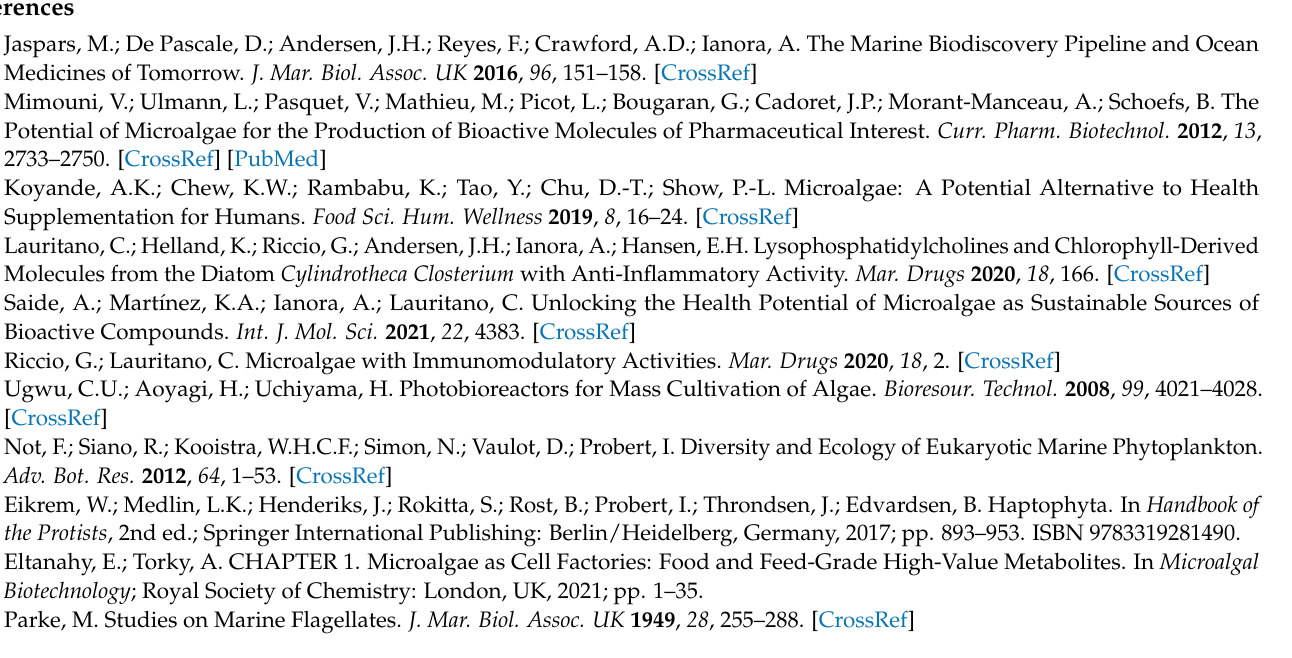
M = missing. Table S1: Isochrysis galbana transcriptome assembly statistics. Table S2: Differentially expressed